Question: What does this figure show? Answer in one sentence.
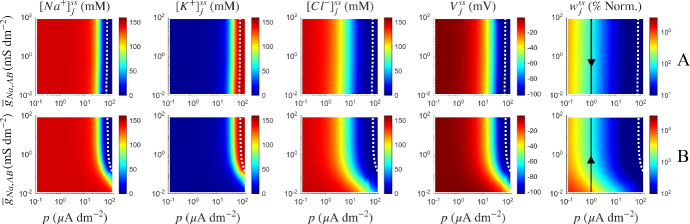
Answer: Steady-state values of compartments A (top) and B (bottom) as functions of \documentclass[12pt]{minimal} \usepackage{amsmath} \usepackage{wasysym} \usepackage{amsfonts} \usepackage{amssymb} \usepackage{amsbsy} \usepackage{mathrsfs} \usepackage{upgreek} \setlength{\oddsidemargin}{-69pt} \begin{document}$$p$$\end{document} p and \documentclass[12pt]{minimal} \usepackage{amsmath} \usepackage{wasysym} \usepackage{amsfonts} \usepackage{amssymb} \usepackage{amsbsy} \usepackage{mathrsfs} \usepackage{upgreek} \setlength{\oddsidemargin}{-69pt} \begin{document}$$\overline{g}_{Na,AB}$$\end{document} g ¯ N a , A B , shown as heat maps. The black vertical line and arrow indicate that when \documentclass[12pt]{minimal} \usepackage{amsmath} \usepackage{wasysym} \usepackage{amsfonts} \usepackage{amssymb} \usepackage{amsbsy} \usepackage{mathrsfs} \usepackage{upgreek} \setlength{\oddsidemargin}{-69pt} \begin{document}$$p$$\end{document} p is small, decreasing \documentclass[12pt]{minimal} \usepackage{amsmath} \usepackage{wasysym} \usepackage{amsfonts} \usepackage{amssymb} \usepackage{amsbsy} \usepackage{mathrsfs} \usepackage{upgreek} \setlength{\oddsidemargin}{-69pt} \begin{document}$$\overline{g}_{Na,AB}$$\end{document} g ¯ N a , A B slightly decreases \documentclass[12pt]{minimal} \usepackage{amsmath} \usepackage{wasysym} \usepackage{amsfonts} \usepackage{amssymb} \usepackage{amsbsy} \usepackage{mathrsfs} \usepackage{upgreek} \setlength{\oddsidemargin}{-69pt} \begin{document}$$w_A^{ss}$$\end{document} w A ss while substantially increasing \documentclass[12pt]{minimal} \usepackage{amsmath} \usepackage{wasysym} \usepackage{amsfonts} \usepackage{amssymb} \usepackage{amsbsy} \usepackage{mathrsfs} \usepackage{upgreek} \setlength{\oddsidemargin}{-69pt} \begin{document}$$w_B^{ss}$$\end{document} w B ss . The dashed white curve overlays the locus \documentclass[12pt]{minimal} \usepackage{amsmath} \usepackage{wasysym} \usepackage{amsfonts} \usepackage{amssymb} \usepackage{amsbsy} \usepackag